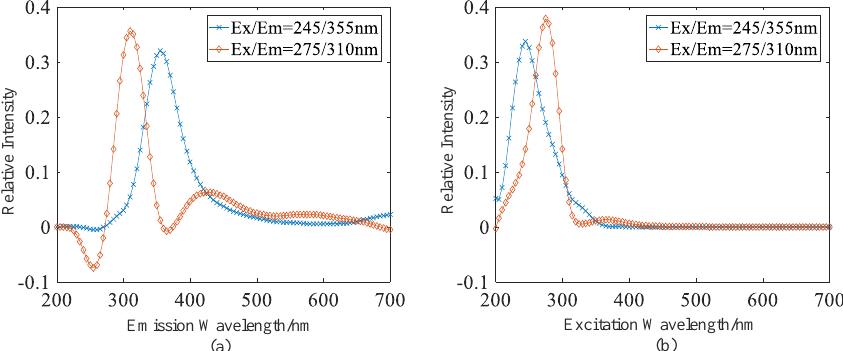
Figure 6. ( a ) Relative emission and ( b ) relative excitation matrices after being decomposed by alternating trilinear decomposition (ATLD).